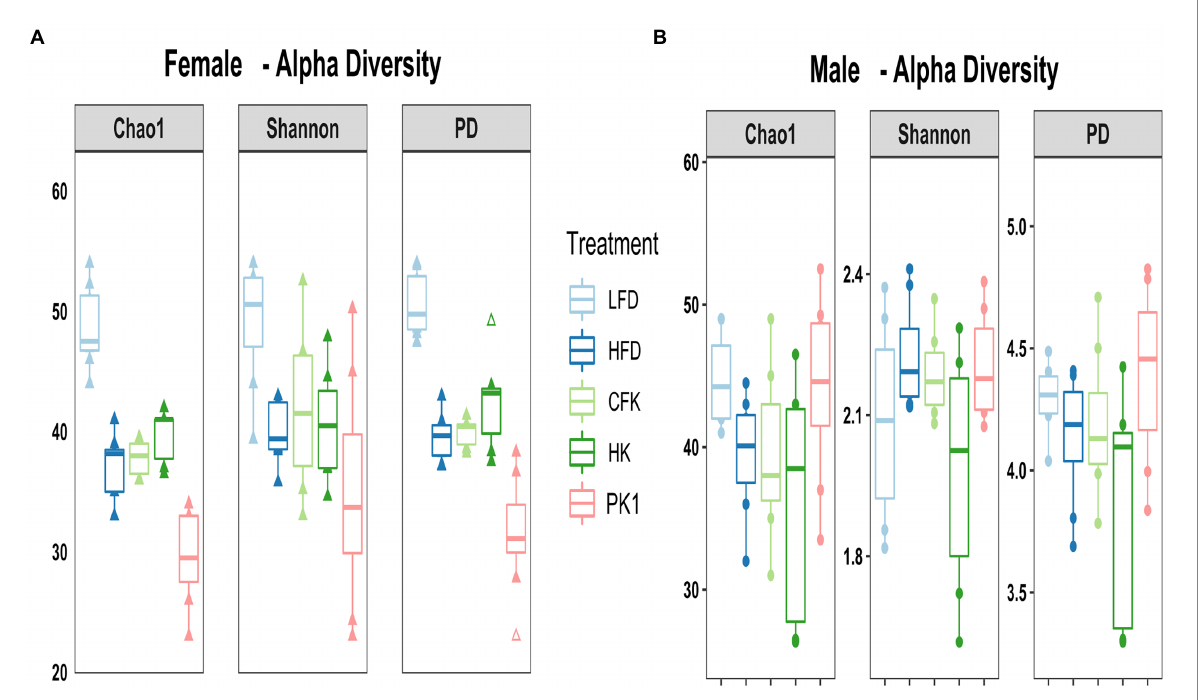
FIGURE 5 Alpha diversity metrics of the cecal microbiota in male/female C57Bl/6 mice fed a control diet or high-fat diet supplemented with milk or different kefir preparations for 8 weeks. (A) Chao1 and PD indices indicated higher microbial diversity and richness in the LFD group ( p < 0.05) and lower diversity in the Kefir group ( p < 0.05) compared to HFD, CFK and HK groups for females with no difference with Shannon diversity index other than LFD maintained higher diversity. (B) No difference was found in male mice after kefir consumption for Chao1, Shannon or PD metrics compared to HFD group ( n = 7–8). Means that do not share a letter are significantly different ( p < 0.05). LFD, mice fed a low fat diet supplemented with freeze- dried milk for 8 weeks; HFD, mice fed a high fat diet supplemented with freeze-dried milk for 8 weeks; PK1, mice fed a high fat diet supplemented with freeze-dried pitched kefir for 8 weeks; CFK, mice fed a high-fat diet supplemented with freeze-dried cell-free kefir; HK, mice fed a high-fat diet supplemented freeze-dried heat-treated